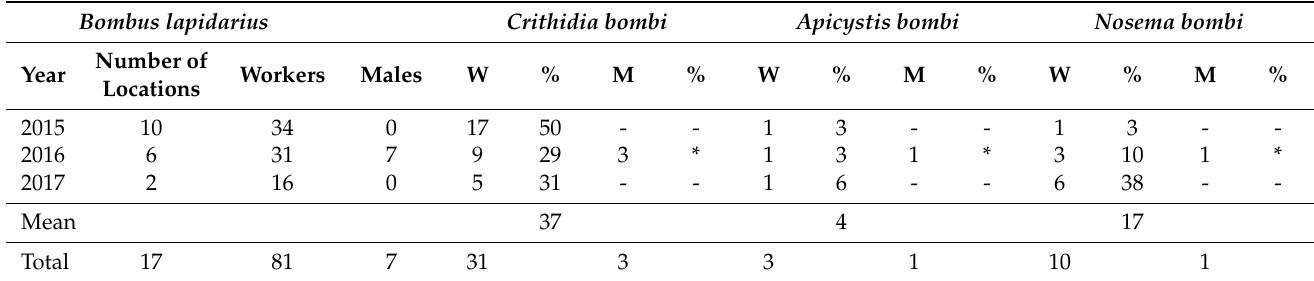
Table 2. Results of laboratory tests, obtained by PCR detection on the species B.